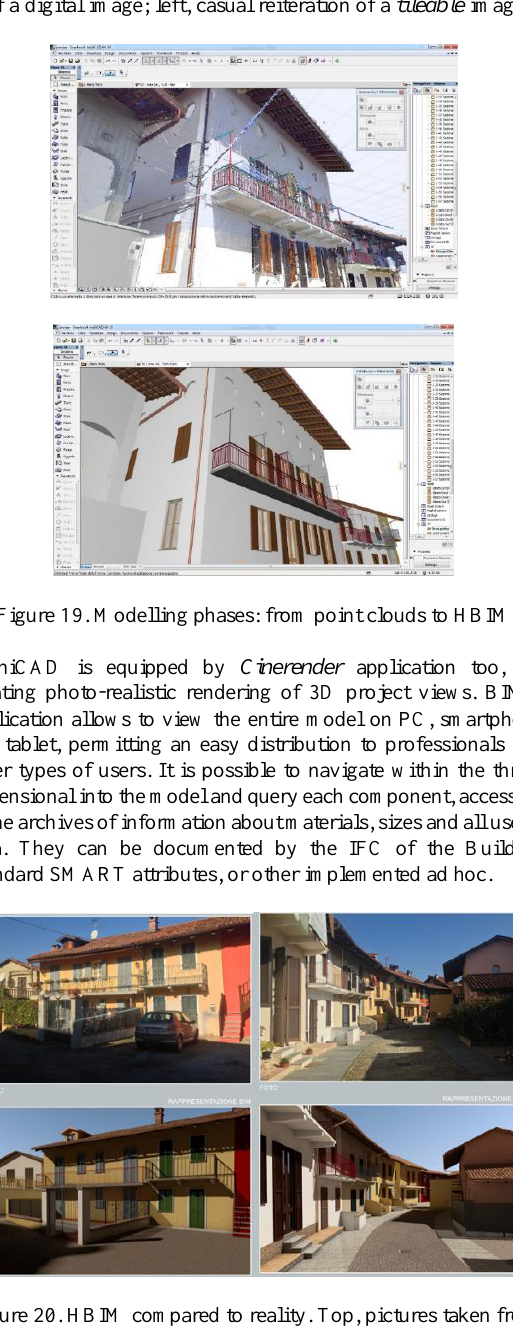
Figure 20. HBIM compared to reality. Top, pictures taken from Pollenzo; down, the corresponding model image